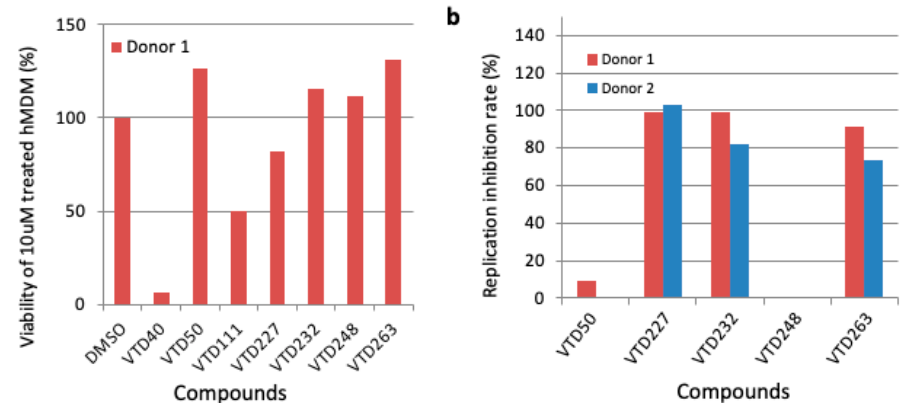
Figure 3. Third screening of Vpr inhibitor using human monocyte-derived macrophages (MDM). ( a ) Human peripheral blood mononuclear cells (PBMCs) were collected from healthy donor 1, and MDM were differentiated from monocytes isolated from human PBMCs. MDM cells were treated with 10 µ M of 7 candidate compounds for 10 days, and the effect on the cell viability of each compound was assessed by a WST-1 assay. ( b ) MDM were differentiated from monocytes isolated from healthy donors 1 and 2, infected with HIV-1 NF462, and then treated with 10 µ M of 4 candidate compounds. After 8 days, we collected the supernatant and assessed the inhibitory effect of the compounds on virus replication by p24 ELISA. Table 2. The inhibitory and cytotoxic concentration of final selected compounds.